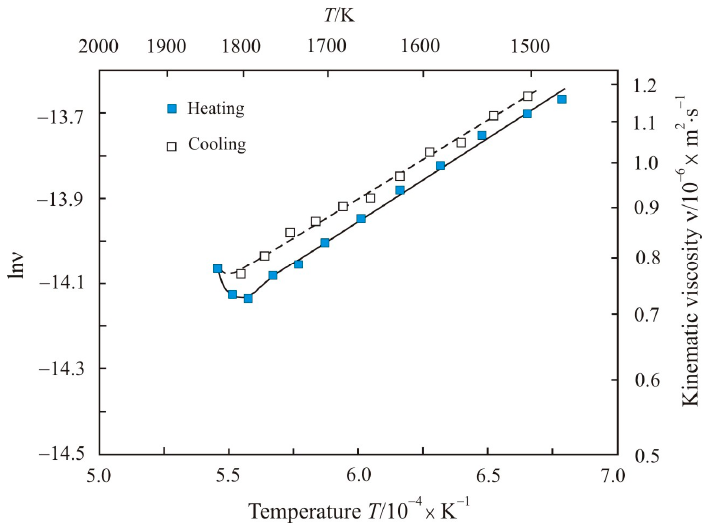
Figure 6. Kinematic viscosity in natural logarithmic scale ln ν as a function of the inverse absolute temperature 10 4 × T − 1 upon heating to the maximum temperature 1820 K and cooling the Fe 84.5 Cu 0.6 Nb 0.5 Si 1.5 B 8.6 P 4 C 0.3 melt.